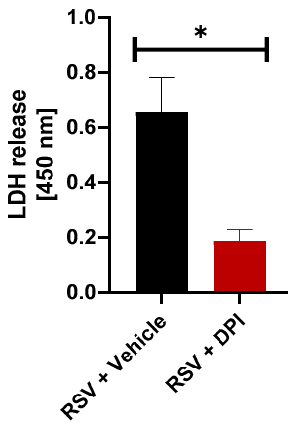
Figure 5. Reactive oxygen species (ROS) regulates lytic cell death of RSV-infected macrophages. Human THP-1 macrophages were infected with RSV (MOI = 1) in the presence of either vehicle (DMSO) or ROS inhibitor diphenyleneiodonium chloride (DPI) (10 µM). LDH release was measured (at OD of 450 nm) at 16 h post-infection ( n = 16 technical replicates from two independent experiments). * p ≤ 0.05 using a Student’s t -test.